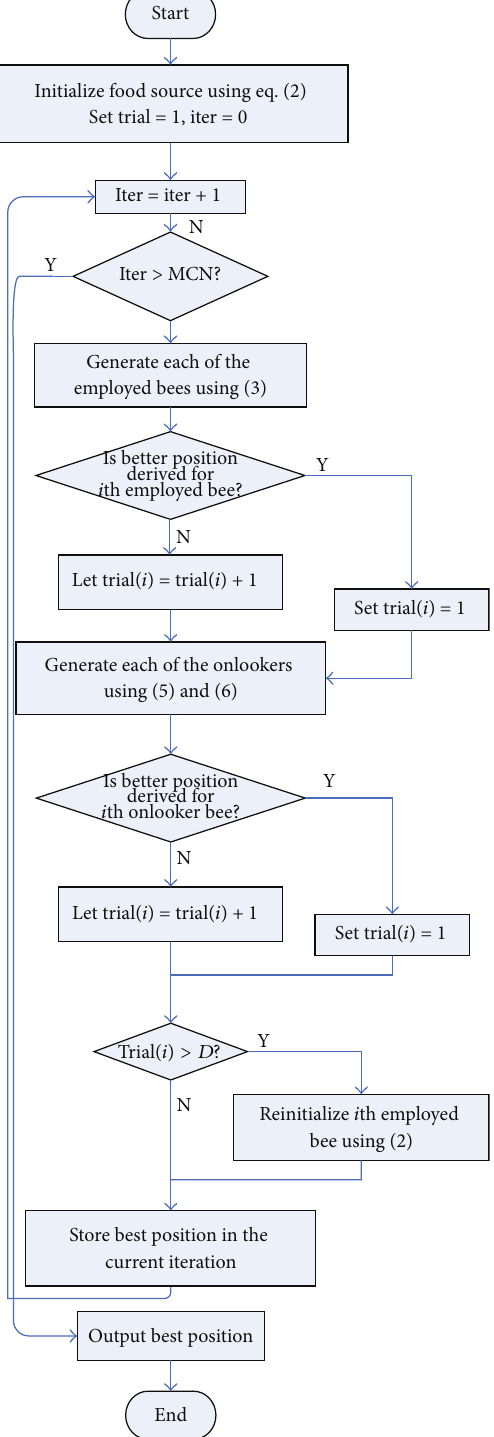
Figure 2: Flow chart of IF-ABC